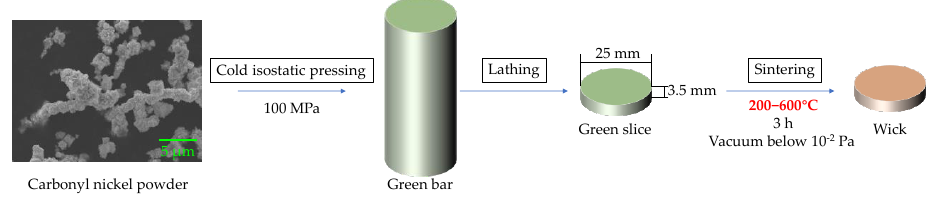
Figure 1. Experimental procedure. Permeability of green slices and wicks was measured and used together with maxi- mum pore diameter to calculate capillary performance. Digital pressure gauges with an accuracy of ±1 kPa and mass flow controllers with an accuracy of ±2.5 mL min −1 were used to determine the permeability according to ISO 4022: 2018, where nitrogen passed through samples at flow rates ranging from 50 mL min −1 to 500 mL min −1 . Absolute alco- hol, nitrogen and a digital pressure gauge with an accuracy of ± 1 kPa were used to deter- mine the bubble point pressure P b of samples according to ISO 4003: 1977. The maximum pore diameter d 𝑚𝑎𝑥 is calculated by Equation (1):